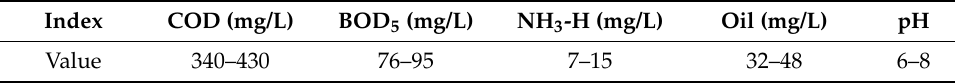
Table 1. Characteristics of oil refinery